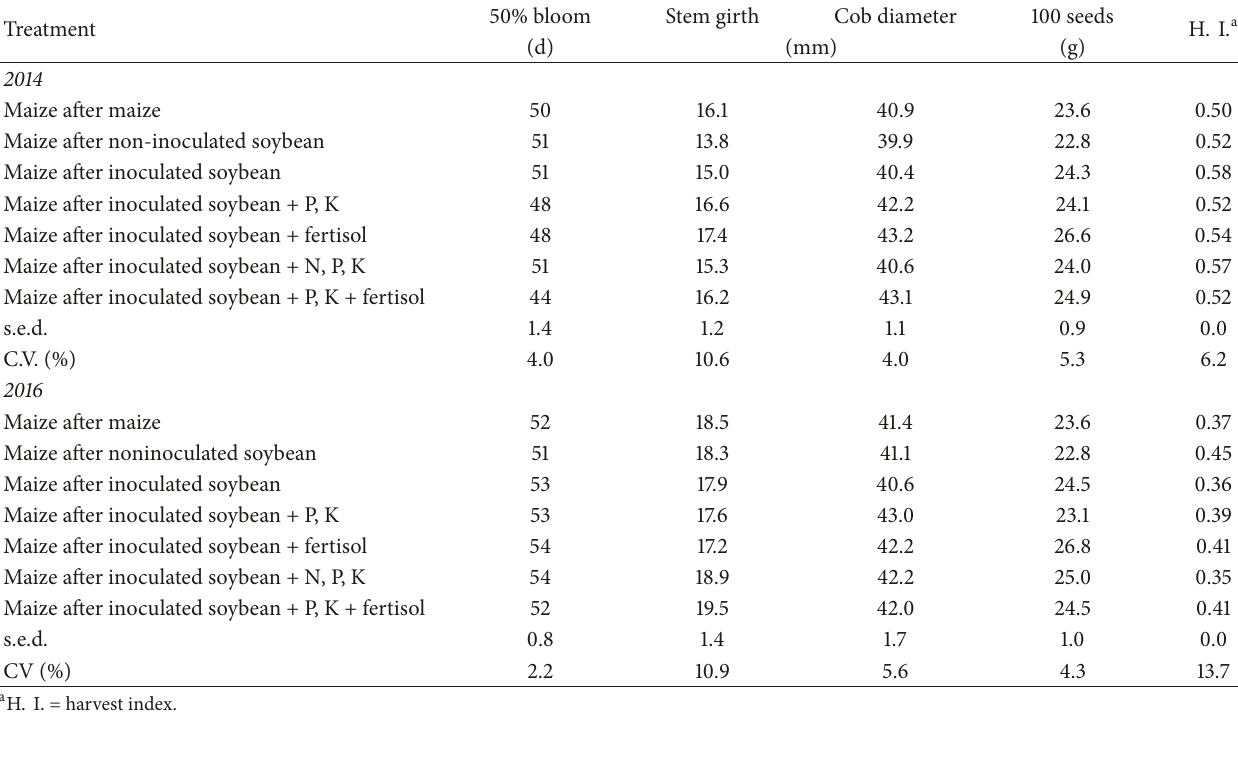
Table 3: Maize growth and development as affected by amended soybean rotation fields in the northern savanna of Ghana. Treatment